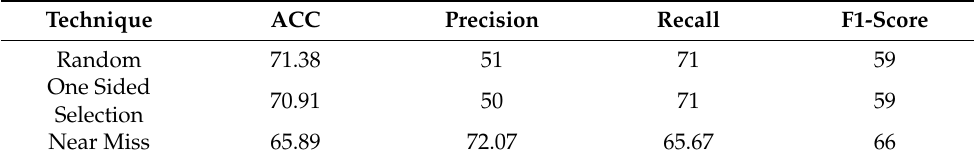
Table 4. Evaluation metrics for the Morris power dataset with undersampling.